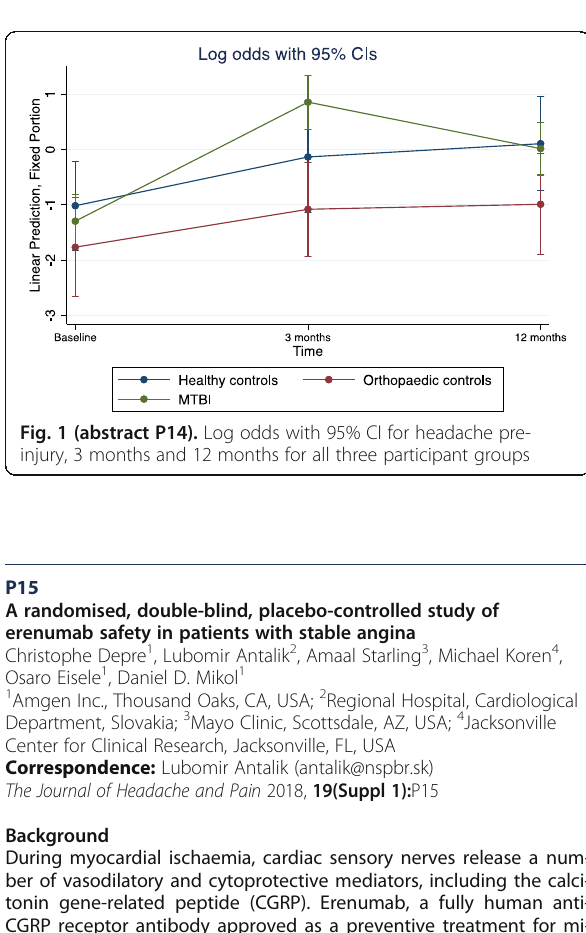
(Table 1). The mean changes from baseline in SBP, DBP and HR dur- ing the safety follow-up period were similar between the two groups. Adverse events, reported by 32% and 27% of patients in placebo and erenumab groups, were mostly singularly reported. One serious AE (atrial fibrillation with placebo) was reported. No clinically signifi- cant changes in serum chemistry or haematology laboratory values were observed. No deaths occurred during the study. Conclusions